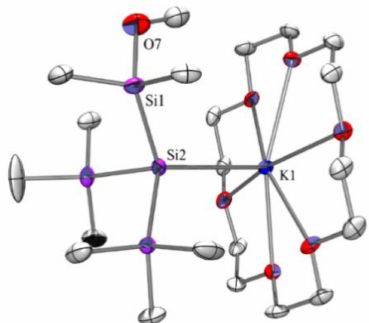
Figure 4. Molecular structure of 2a (thermal ellipsoid plot drawn at the 30% probability level). All hydrogen atoms are omitted for clarity (bond lengths in Å, angles in degrees). Si(1)-Si(2) 2.329(2), Si(2)-Si(4) 2.331(2), Si(2)-K(1) 3.5064(19), Si(1)-O(7) 1.678(5), O(7)-C(1) 1.320(8), Si(1)-Si(2)-Si(4) 101.85(8), Si(1)-Si(2)-Si(3) 101.19(8), Si(4)-Si(2)-Si(3) 102.42(7), Si(1)-Si(2)-K(1) 122.17(7).